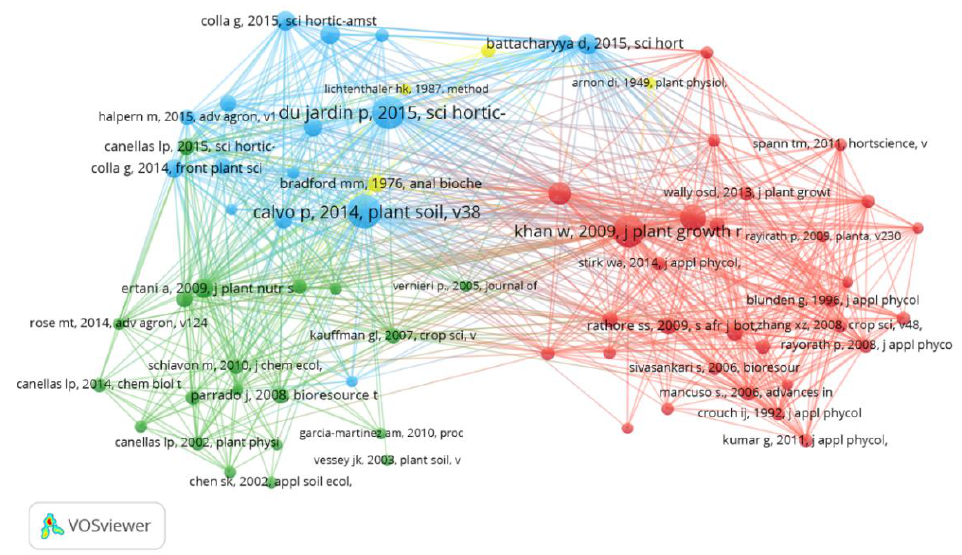
Figure 5. Co-citation analysis